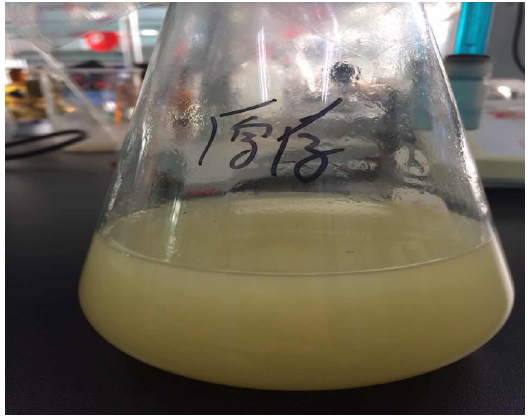
Figure 2: Enrichment culture of Phanerochaete chrysosporium.